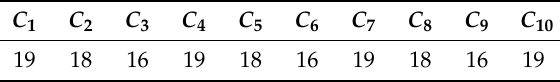
Table 7. The available capacity in each period t .